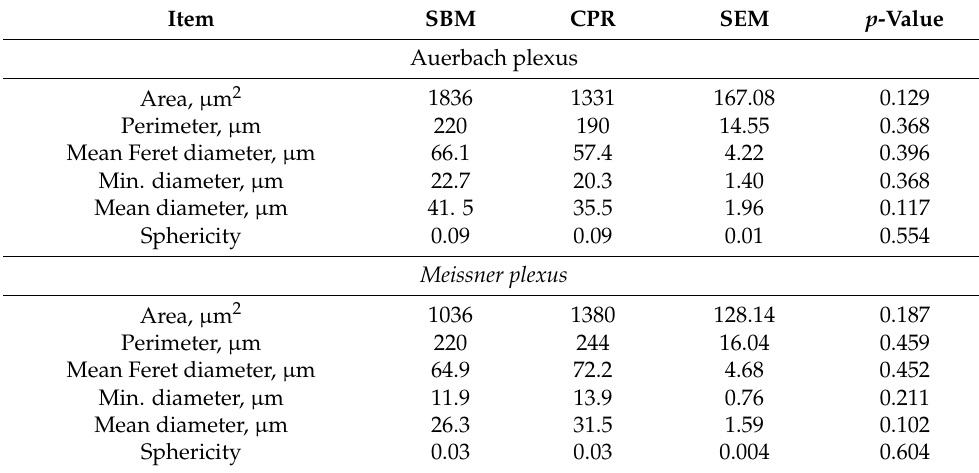
Table 4. Effect of raw chickpea on histomorphometric parameters of nerve plexuses in the duodenum in 42-day-old broiler chickens 1 .